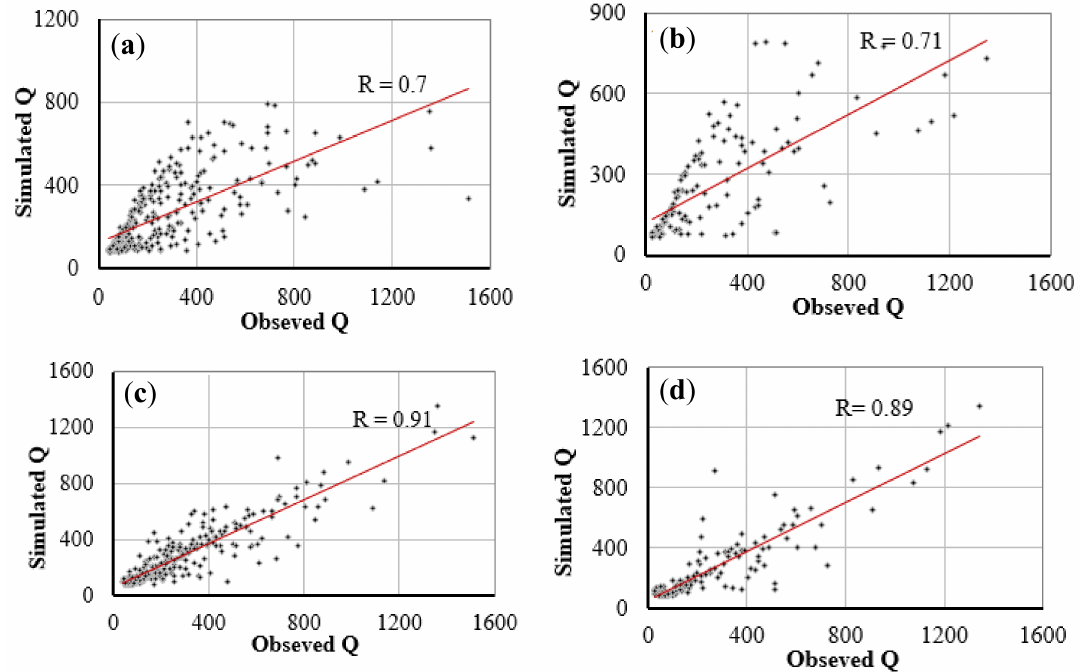
Figure 10. Performance of TDNN and NNRBF (the worst and best techniques) in terms of correlation coefficient for Dez Basin. ( a ) TDNN- training data; ( b ) TDNN- verification data; ( c ) NNRBF- training data; ( d ) NNRBF- verification data.